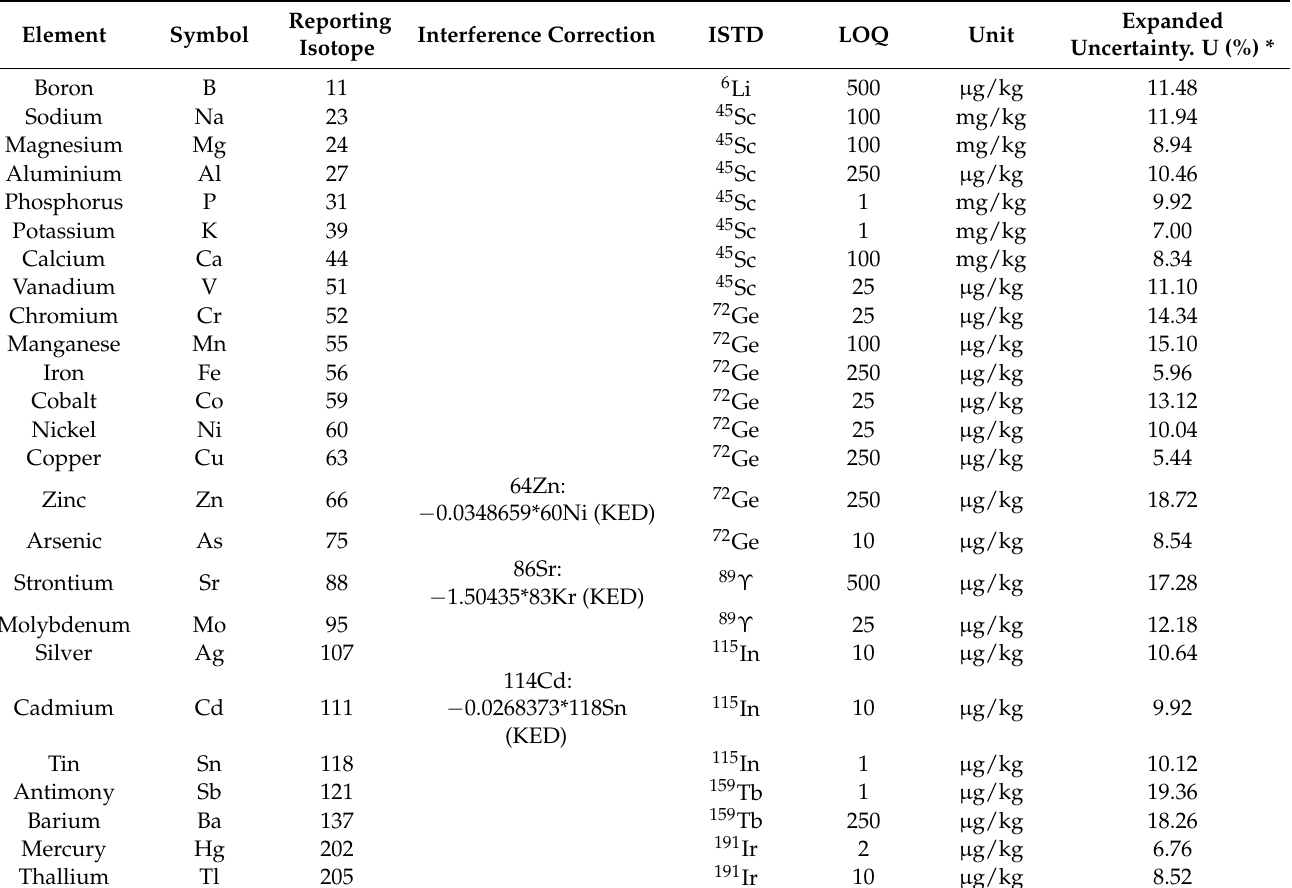
Table 4. Quantification parameters of trace and macro